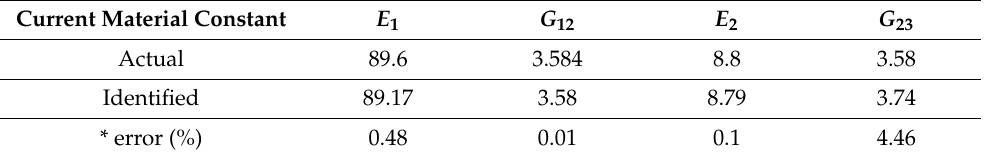
Table 11. Current material constants of graphite/epoxy [0 ◦ ] 8 cantilever plate ( a / h = 20). Current Material Constant E 1 G 12 E 2 Actual Identified * error